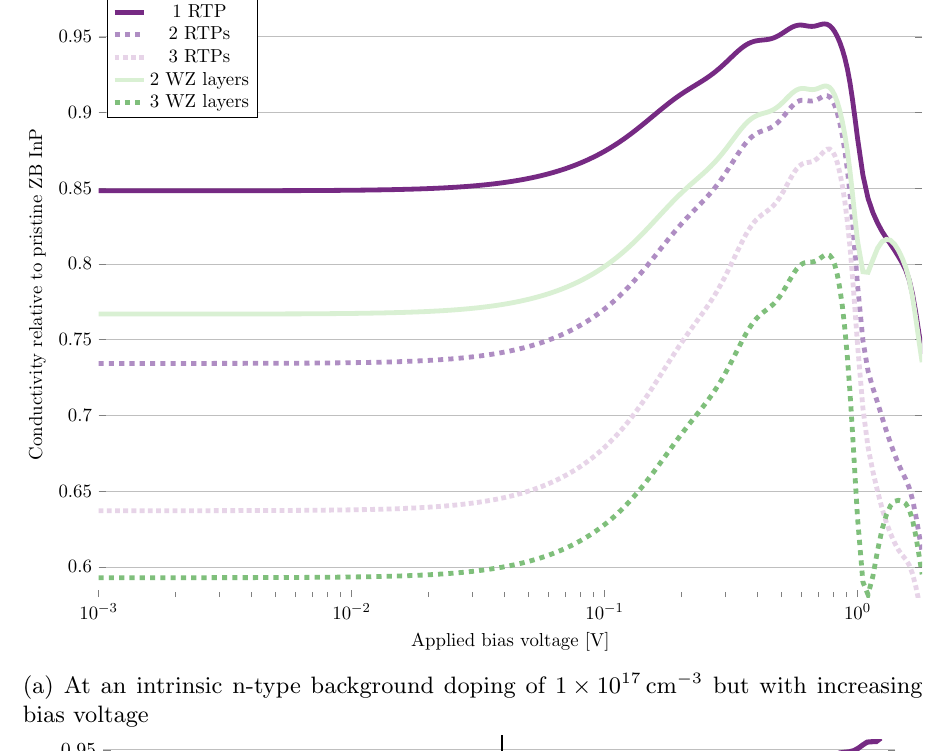
(a) At an intrinsic n-type background doping of 1 bias voltage